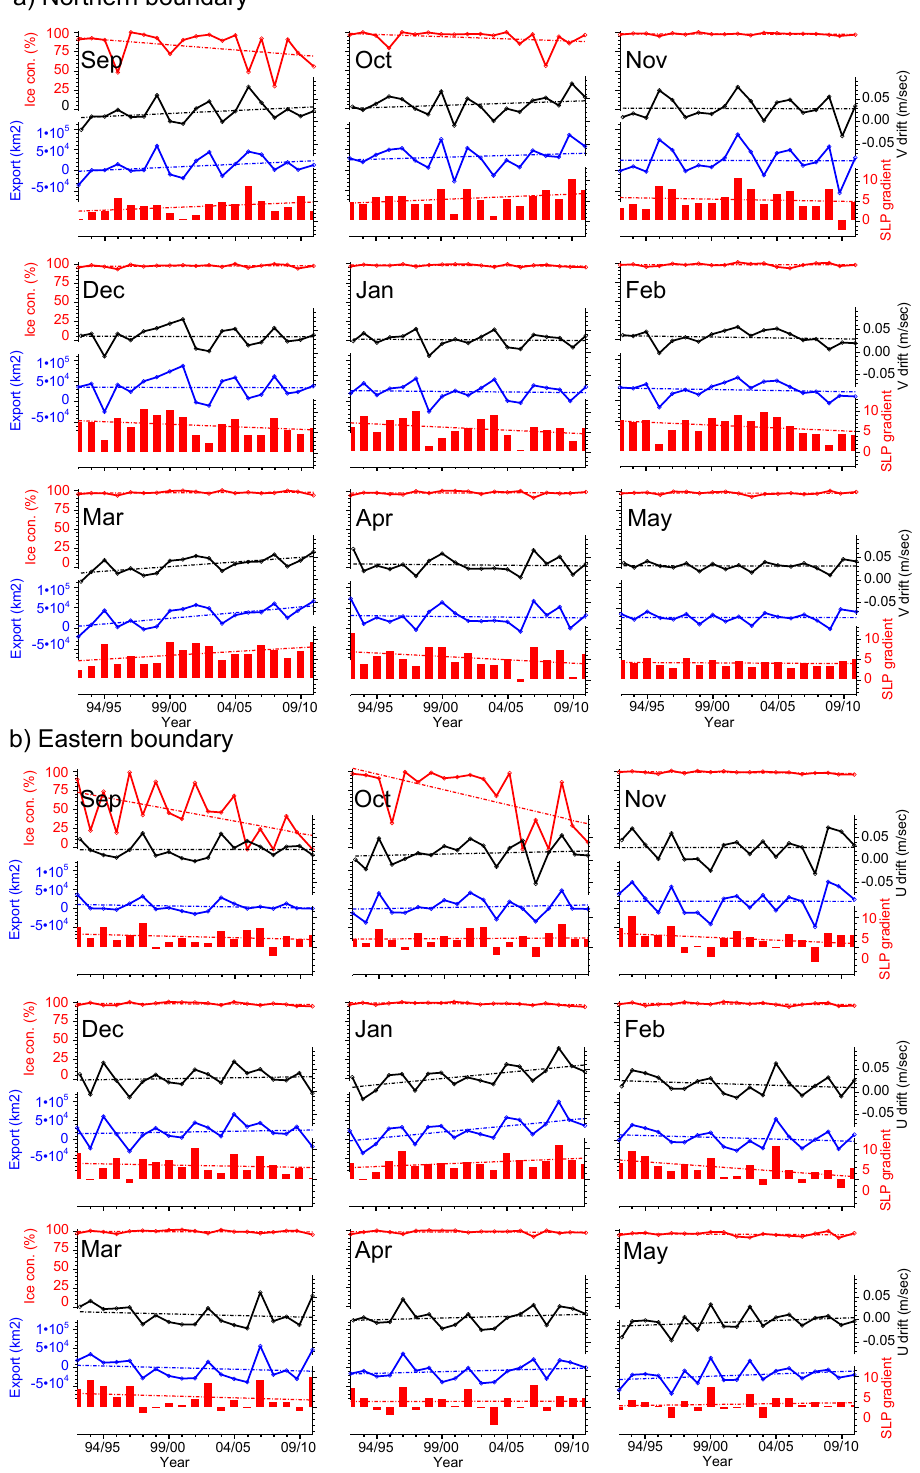
Fig. 7. Time series and trends of average monthly ice concentration, ice drift, ice area flux and sea level pressure gradient across northern boundary (a) and eastern boundary (b) between 1992 and 2011. The average monthly ice concentration is represented by the red line (upper left axis, given in %). The cross-boundary monthly ice drift ( V and U component for (a) and (b) given in cms − 1 , black line) and the monthly ice area flux (given in 10 4 km 2 , blue line) refer to the upper right and lower left axis, respectively. The cross-boundary sea level pressure gradient (given in hPa, lower right axis) is indicated by the red bars.